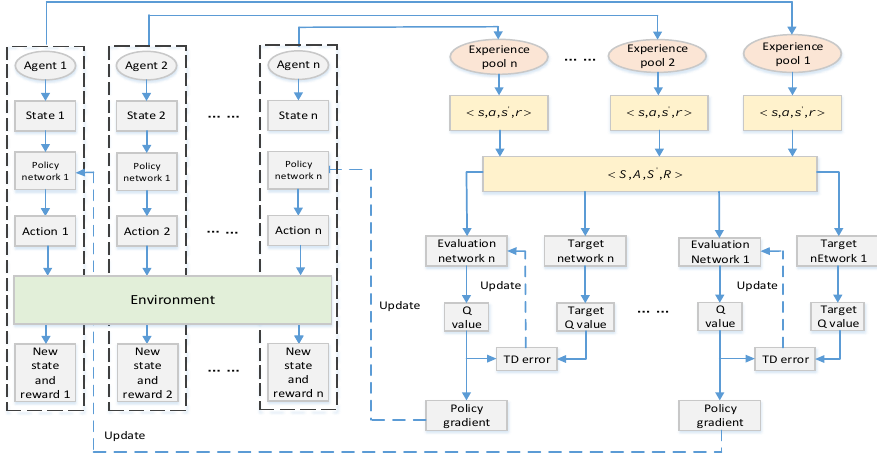
Figure 10. The framework of MADDPG